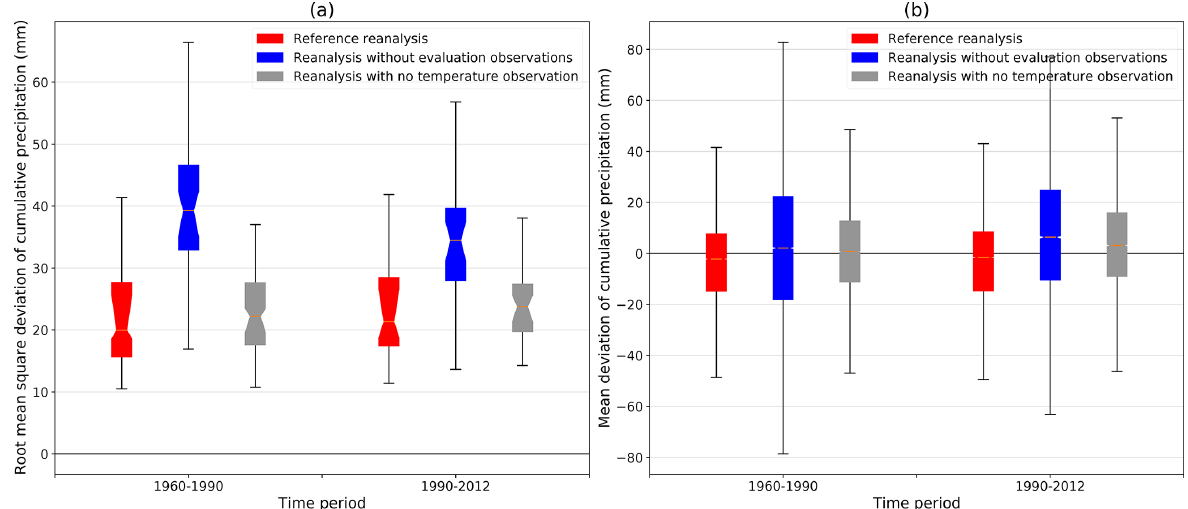
Figure 11. Root mean square deviation (a) and mean deviation (b) between the simulated monthly cumulated precipitation and the corre- sponding homogenized series form the periods 1960–1990 and 1990–2012 for three different version of the S2M reanalysis (see Sect.